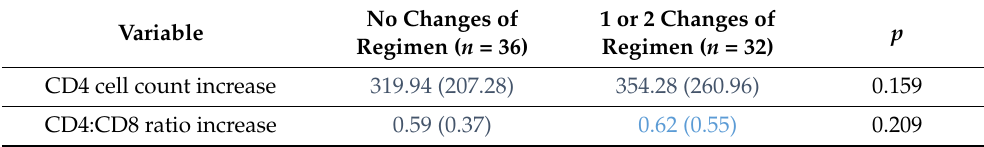
Table 8. The results of CD4 cell count and CD4:CD8 ratio normalization are presented in Table 9. Table 8. CD4 cell count and CD4:CD8 recovery depending on changes in the ART regimen. Variable